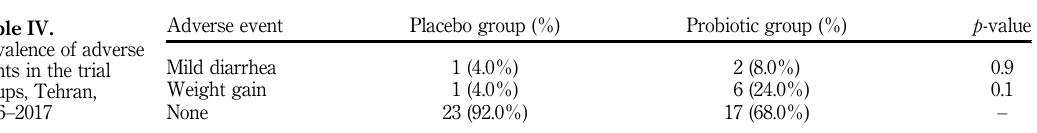
Table IV. Prevalence of adverse events in the trial groups,